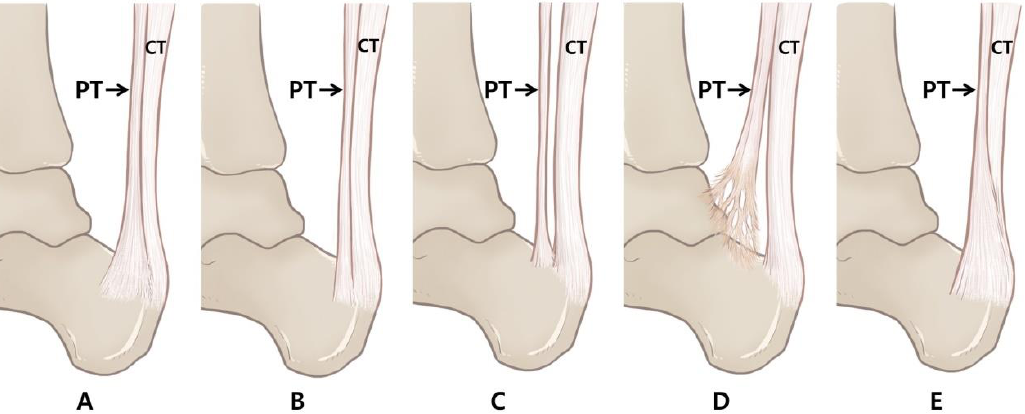
Figure 2. Schematic drawings of the classification of the PT according to insertion type. Medial view of the right leg with the PT. ( A ) Type 1 is a form that expands in a fan shape on the medial side of the CT before tendon insertion and is inserted into the calcaneal tuberosity; ( B ) Type 2 is inserted into the calcaneal tuberosity along the medial side of the CT similar to Type 1, but does not take a fan shape; ( C ) Type 3 is characterized by insertion into the calcaneus anterior to the CT; ( D ) Type 4 is a form in which the insertion is fused to the deep crural fascia, not to the calcaneus or calcaneal tuberosity; ( E ) Type 5 is characterized by a very wide insert surrounding the medial and posterior surface of the CT. CT: calcaneal tendon; PT: plantaris tendon (black arrow indicates plantaris tendon).